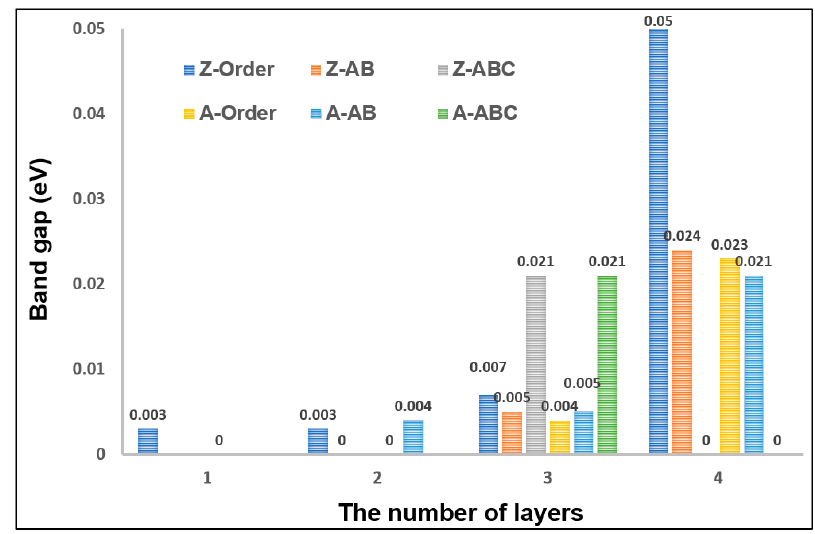
Figure 4. The comparison of the band gap of six types of the stacked graphene with one to four layers, such as Z-Order, Z-AB, Z-ABC, A-Order, A-AB, and A-ABC.